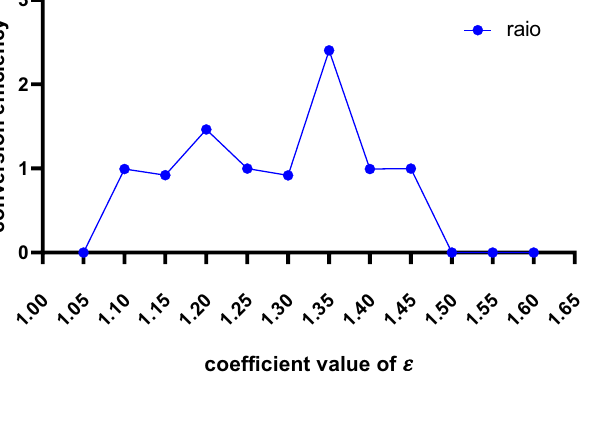
Figure 6. Efficiency of CO 2